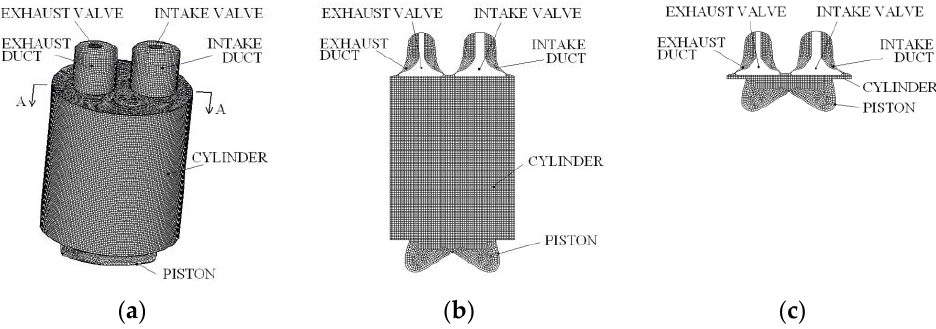
Figure 3. Computational mesh. ( a ) 3D view at BDC. ( b ) AA section at BDC. ( c ) AA section at TDC.